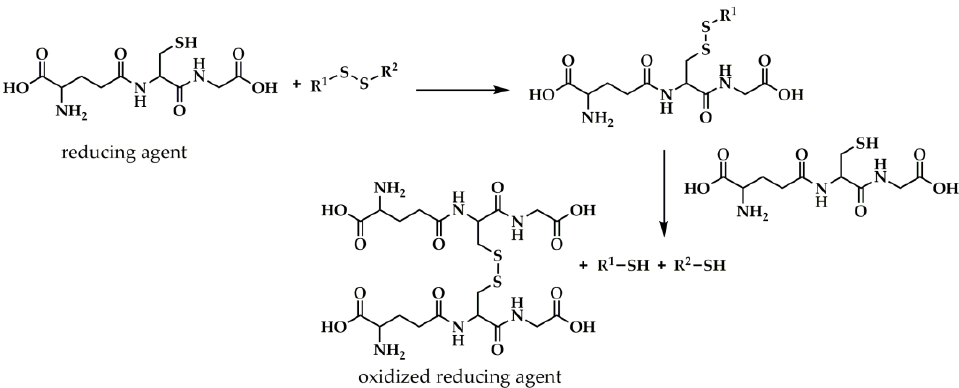
Figure 8. Mechanism of the reductive cleavage of disulfide bonds under the impact of the thiol- containing